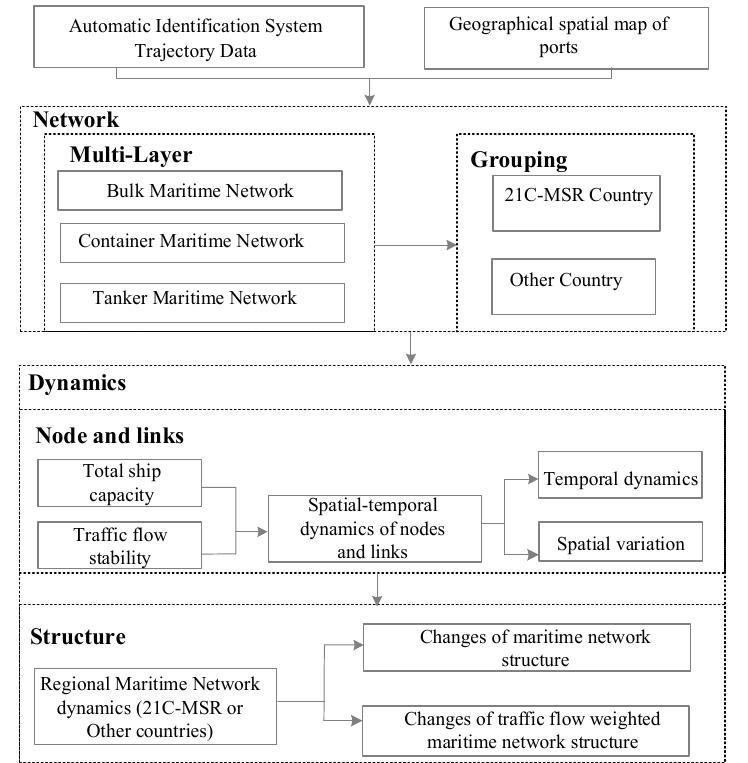
Figure 1. Proposed analytical framework.